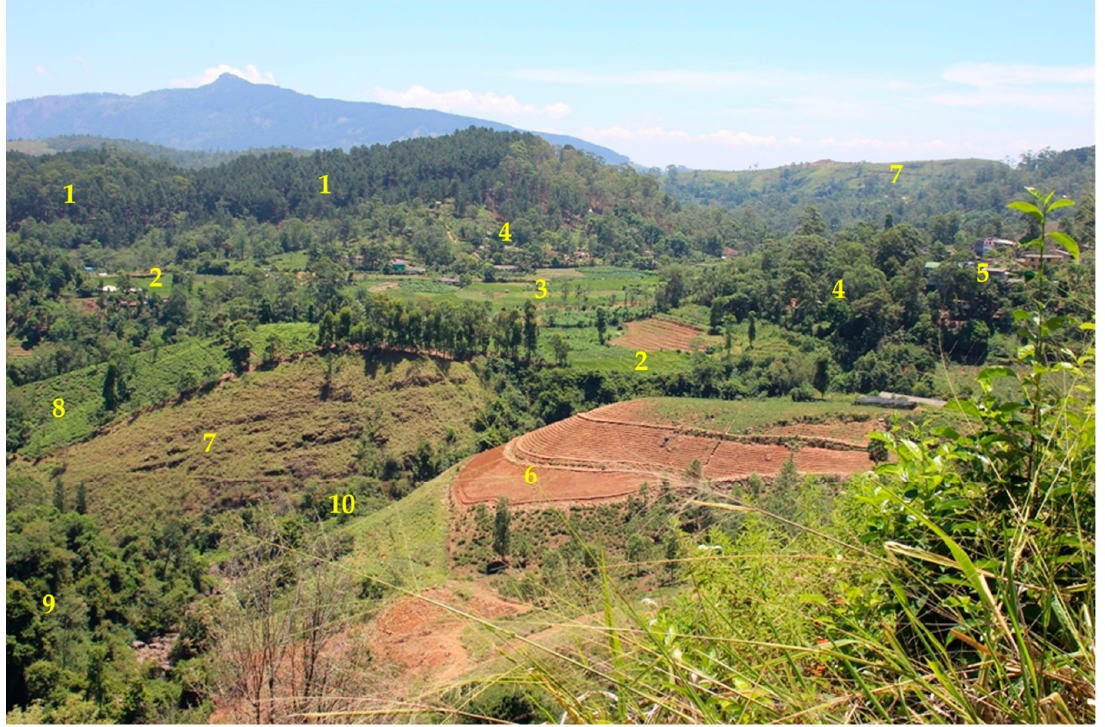
Figure 3. Image shows a heterogeneous landscape in the wet zone highlands. 1: Forest plantation, 2: Rice paddy, 3: Vegetable cultivation, 4: Home garden, 5: Periurban, 6: Recent land clearance